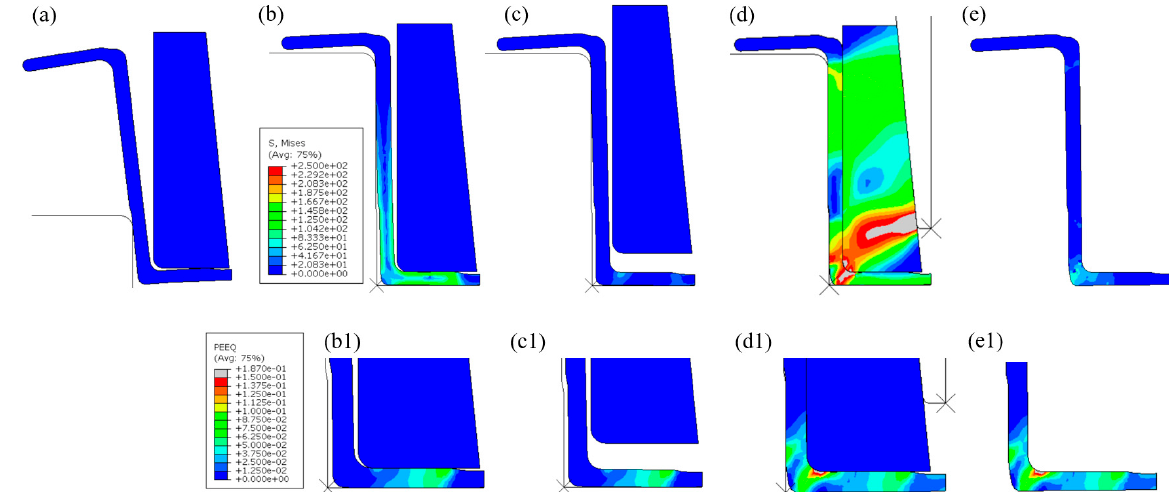
Figure 7. Stress and strain evolution during the TSLB process: Von Mises stress in ( a ) initial state; ( b ) inserting stage; ( c ) releasing stage; ( d ) calibration stage; and ( e ) springback stage and ( b1 , c1 , d1 , e1 ) the corresponding equivalent plastic strain distribution in the last four stages.